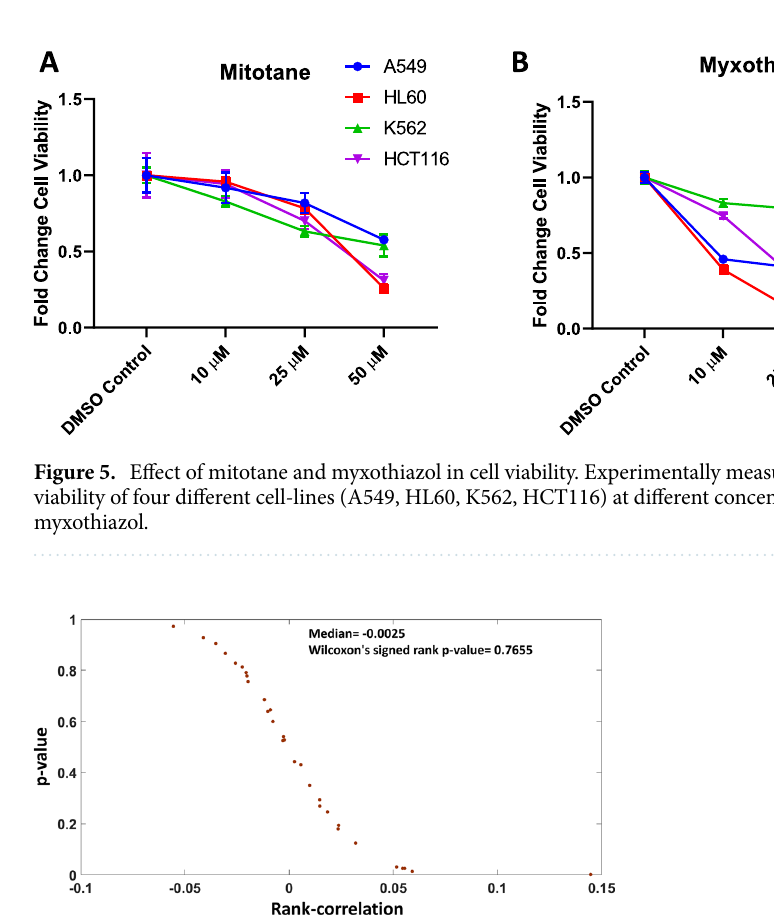
Figure 6. Comparison of gene knockout simulation results with DEMETER database. Distribution of measured Spearman rank-correlation between predicted FCG of genes using GSMM and experimental data from DEMETER for the 30 cell-lines. The p -values were measured using permutation